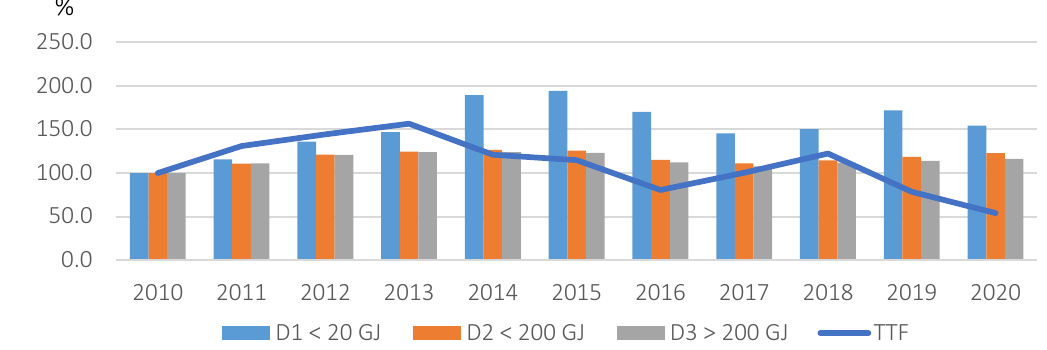
Figure 3. Change in the tariff for natural gas by category of industrial enterprises, excluding taxation in the EER